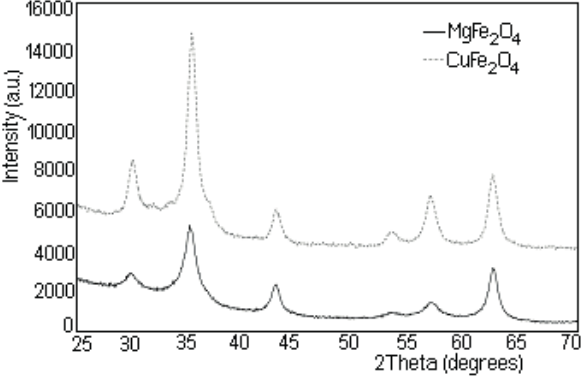
O (M II = Mg, Cu) ferrites. 2 4